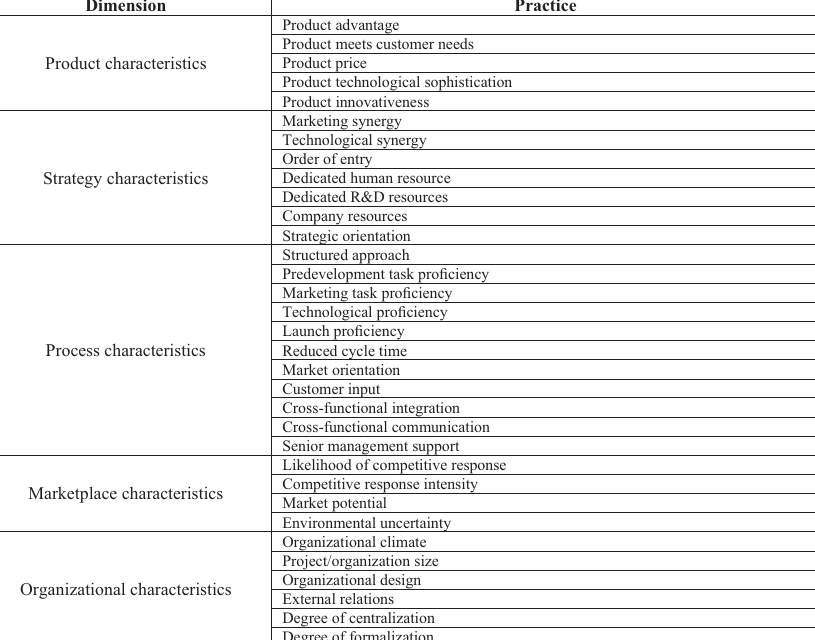
Figure 2. Practices for NPD